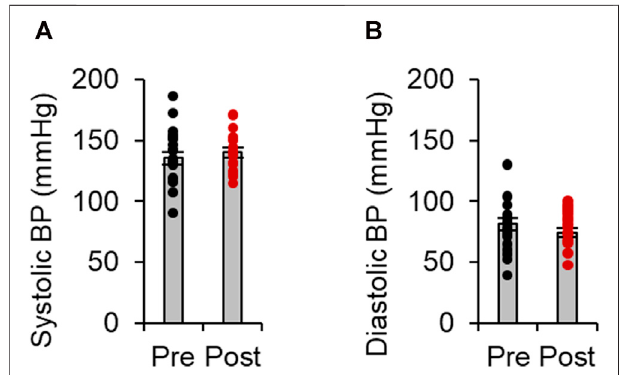
FIGURE 2 | Effects of fasudil on blood pressure levels. Systolic (A) and diastolic (B) blood pressure (BP) before and after treatment with fasudil(n (cid:1) 15). Data represent the mean ± s